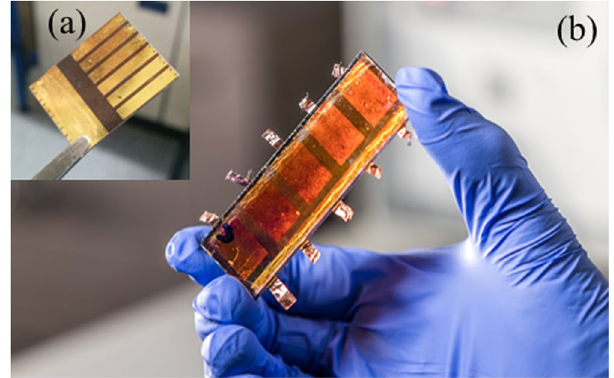
Figure 1. Part ( a ) and ( b ) show images of completed small-area and large-area PSC devices respectively.